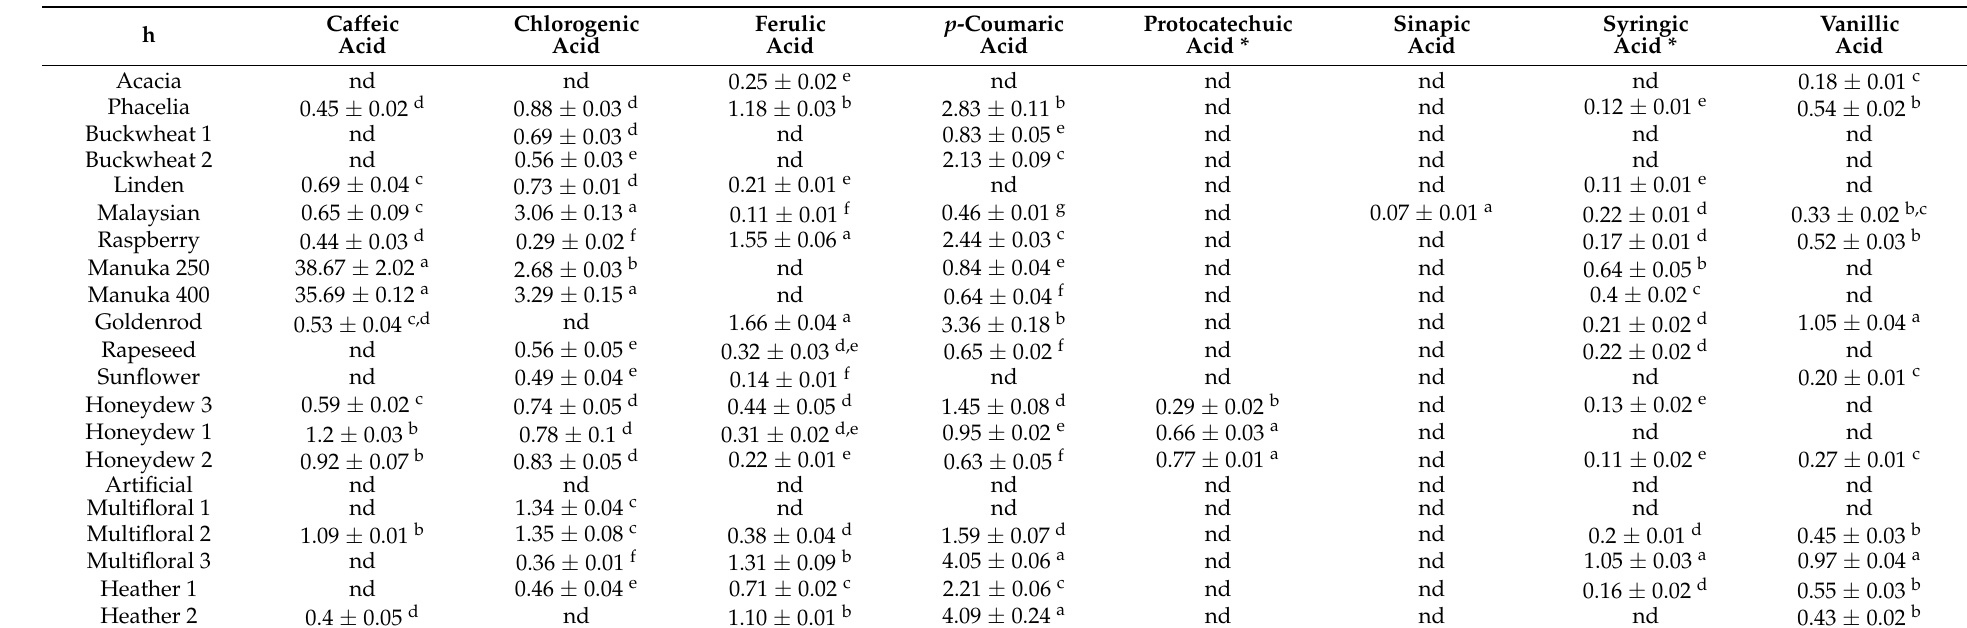
Table 2. Phenolic compounds of honeys—phenolic acids [mg kg − 1